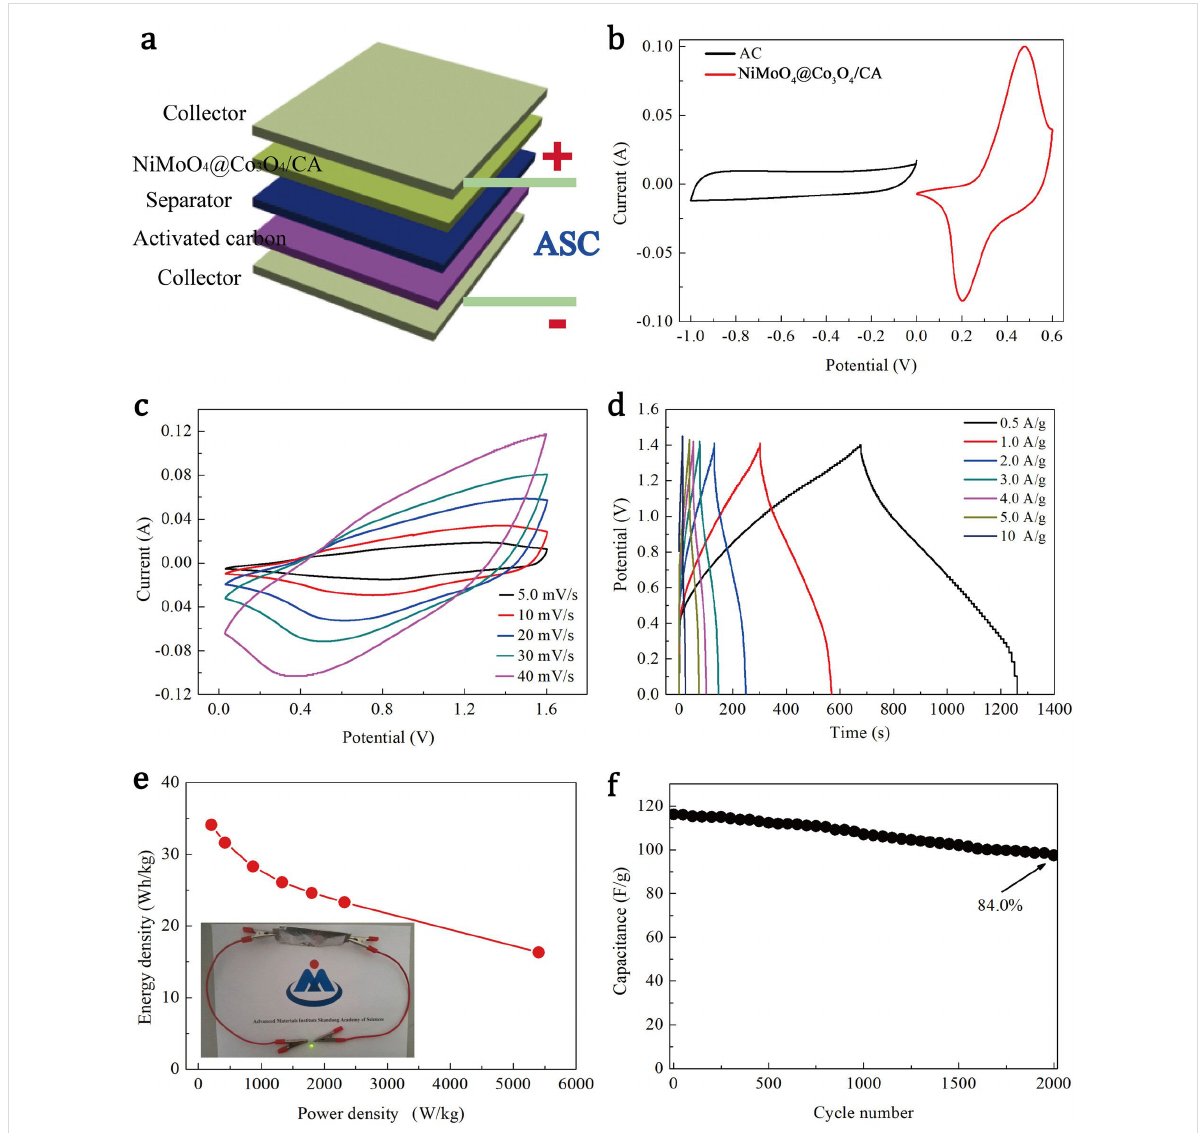
Figure 7: Electrochemical performance of the NiMoO 4 @Co 3 O 4 /CA//AC ASC. (a) Schematic illustration of the ASC device; (b) CV curves of the AC and NiMoO 4 @Co 3 O 4 /CA electrodes at a scan rate of 5.0 mV/s; (c) CV curves at different scan rates; (d) GCD curves at different values of the current density; (e) Ragone plot; the inset shows the green LED powered by the assembled ASC device; (f) cycle performance of the ASC device at a cur- rent density of 0.5